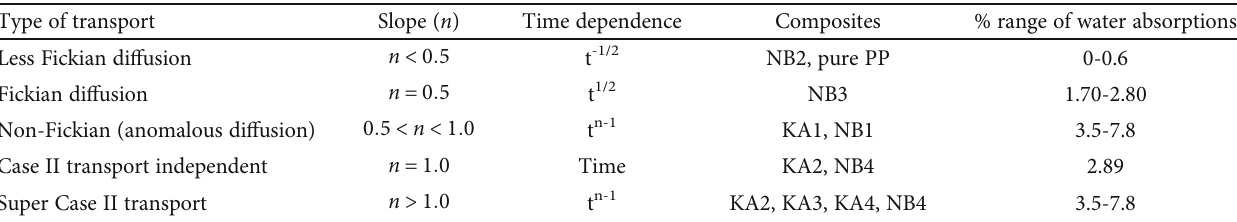
Table 7: Water transport mechanism for produced